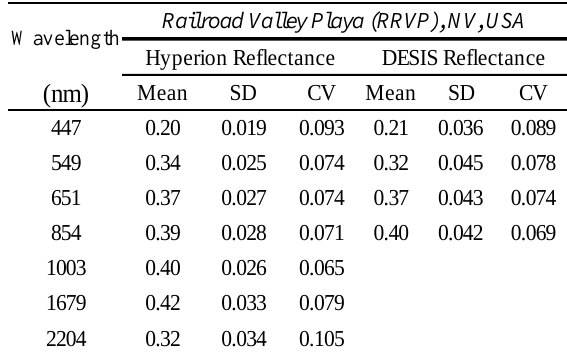
Table 1. Comparing for Railroad Valley Playa (RRVP)